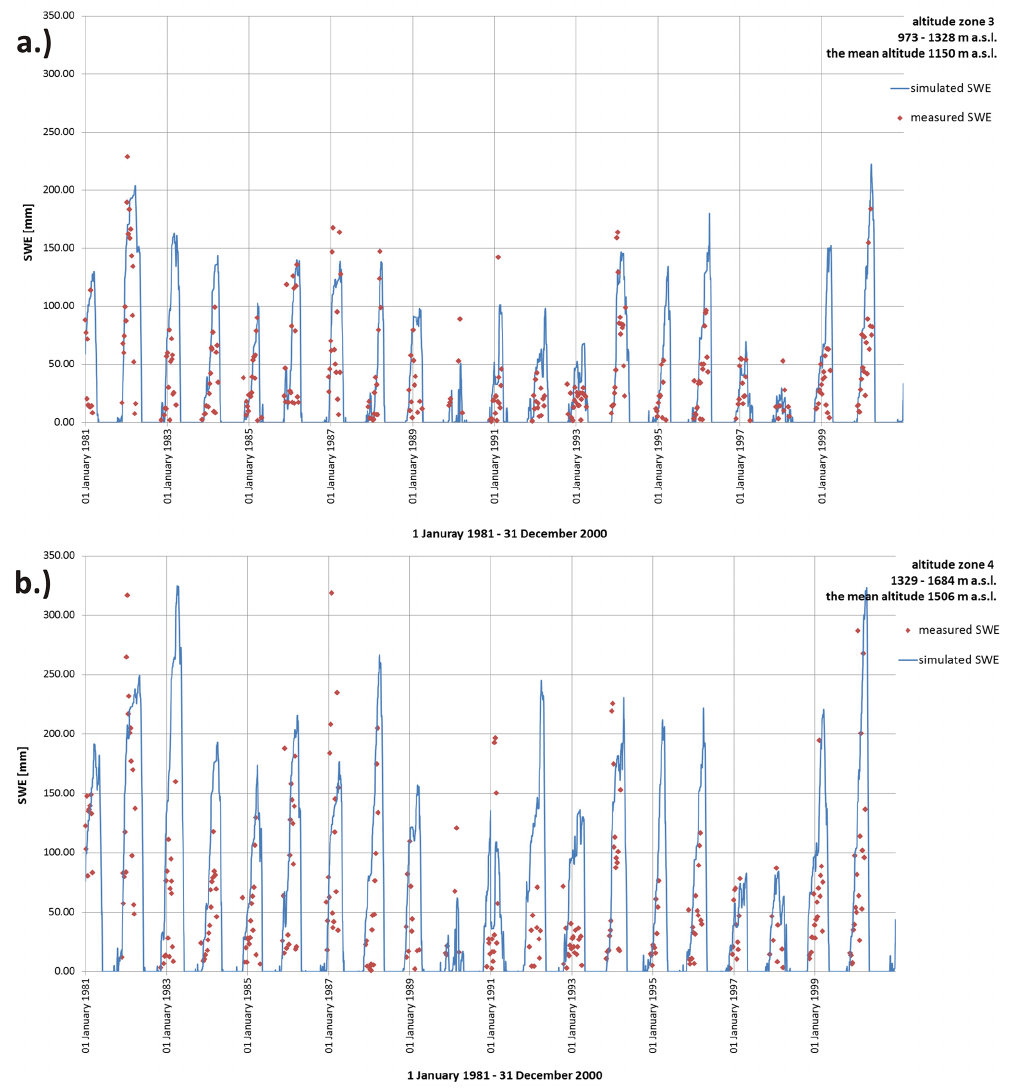
Figure 2. Comparison of simulated and measured SWE in (a) the third and (b) the fourth altitude zones of the Upper Hron during the period of